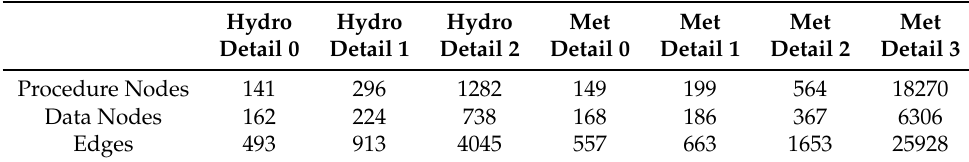
Figure 5. Disk space used with different snapshot sizes and detail levels. Table 5. Size of provenance